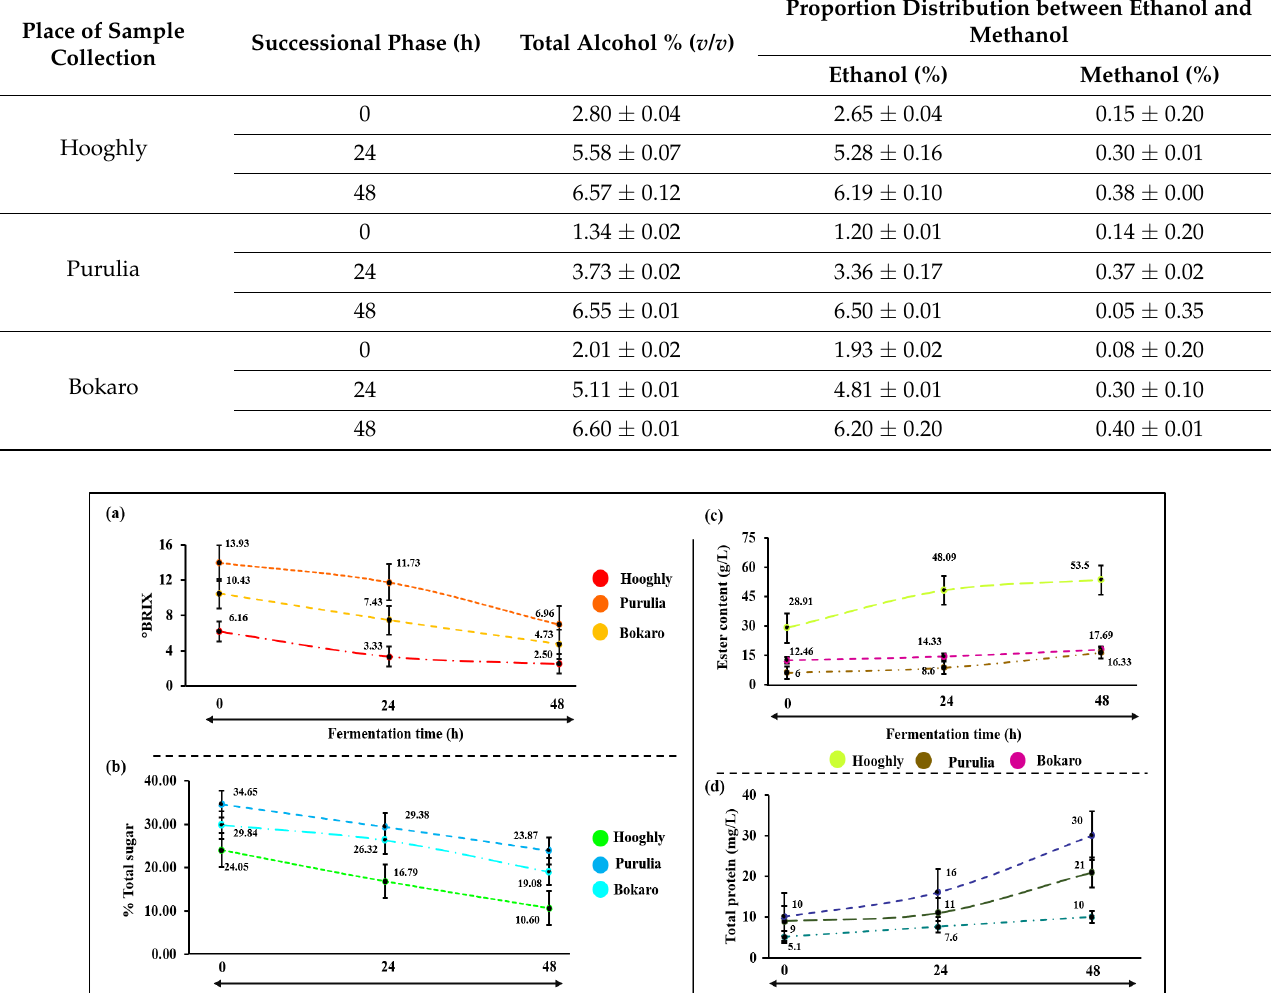
Table 2. Successional changes in the alcohol content throughout the fermentation of toddy and corresponding alcoholic proportion distribution between ethanol and methanol.